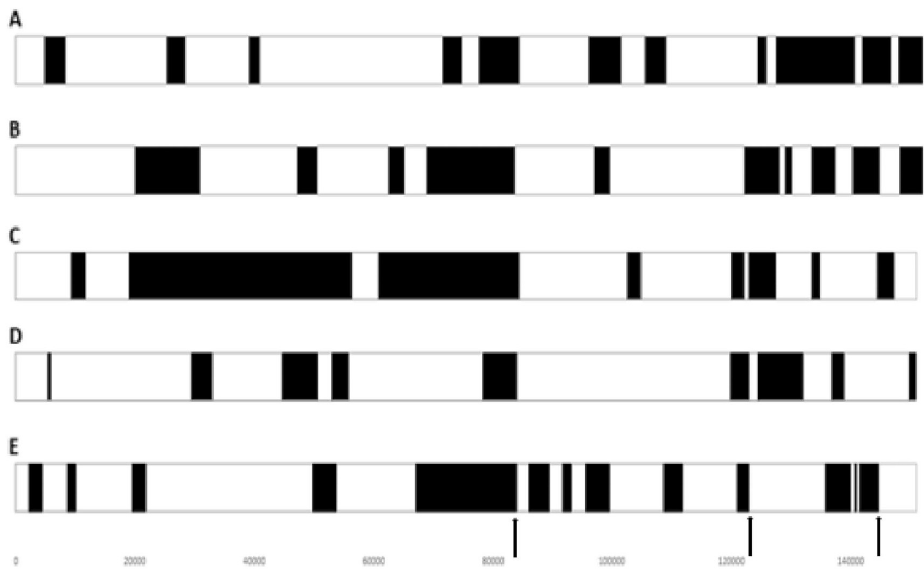
Figure 5. Graphical representation of the position of the predicted recombination events across the five strains with the highest statistical significance. The events are indicated in black in the white backbone of the viral genome. Possible regions selected for by recombination are indicated by arrows (positions 80,000 bp, 124,000 bp and 141,000 bp). ( A ) LSDV/KZ-Konstanay/Kazakhstan/2018.